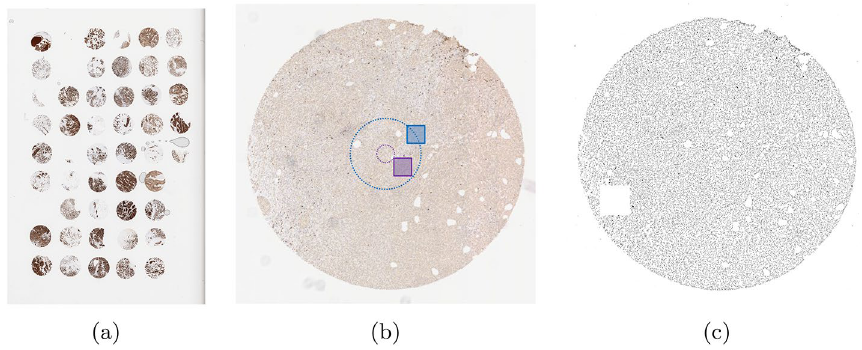
Figure 3. ( a ) Example of TMA with multiple cores processed simultaneously by histochemical processing. ( b ) Example of a single core extracted from the digital image of TMA. ROI selection algorithm pictured with increased size of virtual circles and ROI for better visualization. ( c ) Binary map depicting the seamless detection of nuclei with CHISEL processing on sample presented in the middle column. (Image was inverted for better visual